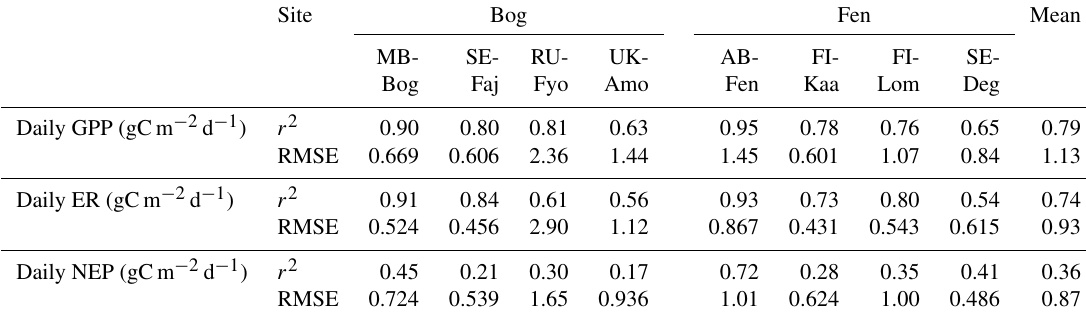
Table 6. Summary of statistics of model performance with respect to GPP, ER, and NEP (gCm − 2 day − 1